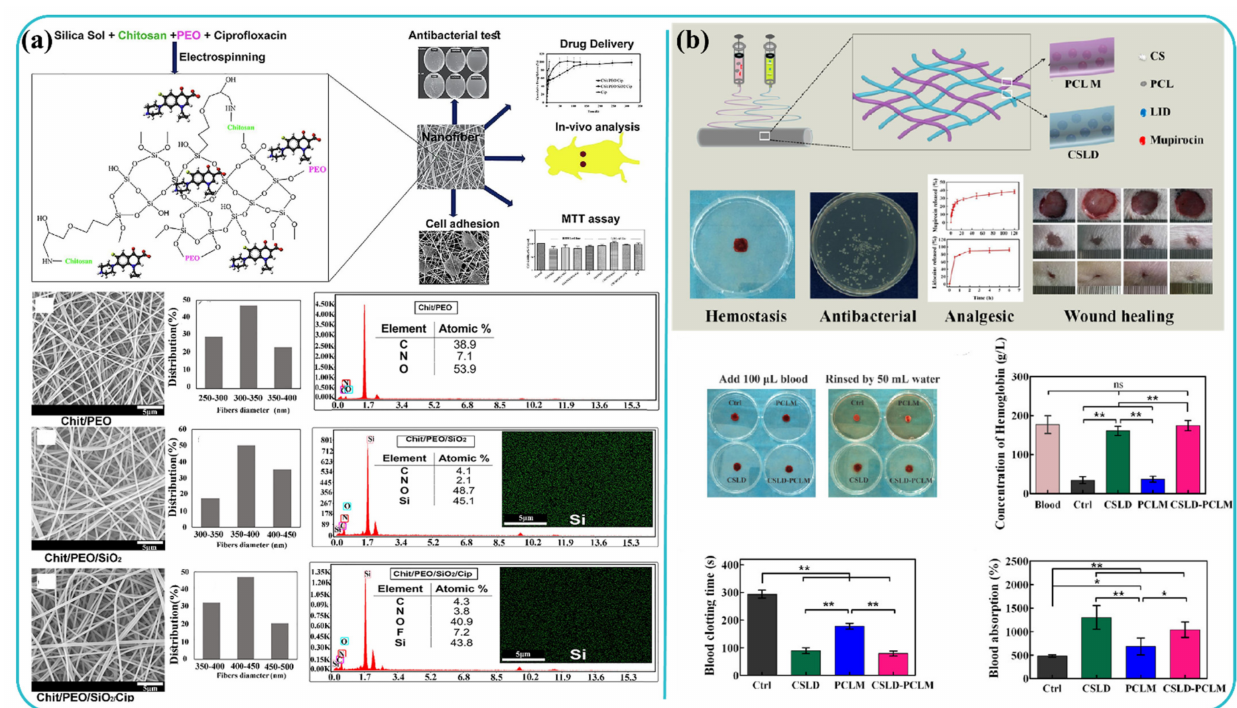
Figure 7. ( a ) Interactions of the inorganic framework with chitosan and polyethylene oxide; SEM images, fibers size distribution, EDX and X-ray mapping [152]. ( b ) Schematic Illustration of fabrication process of nanofiber scaffolds; concentration of hemoglobin in blood clots on scaffolds; blood clotting time and blood absorption capacity of the medical gauze control and PCLM, CSLD, and CSLD-PCLM nanofiber scaffolds * p < 0.05, ** p < 0.01 [155].